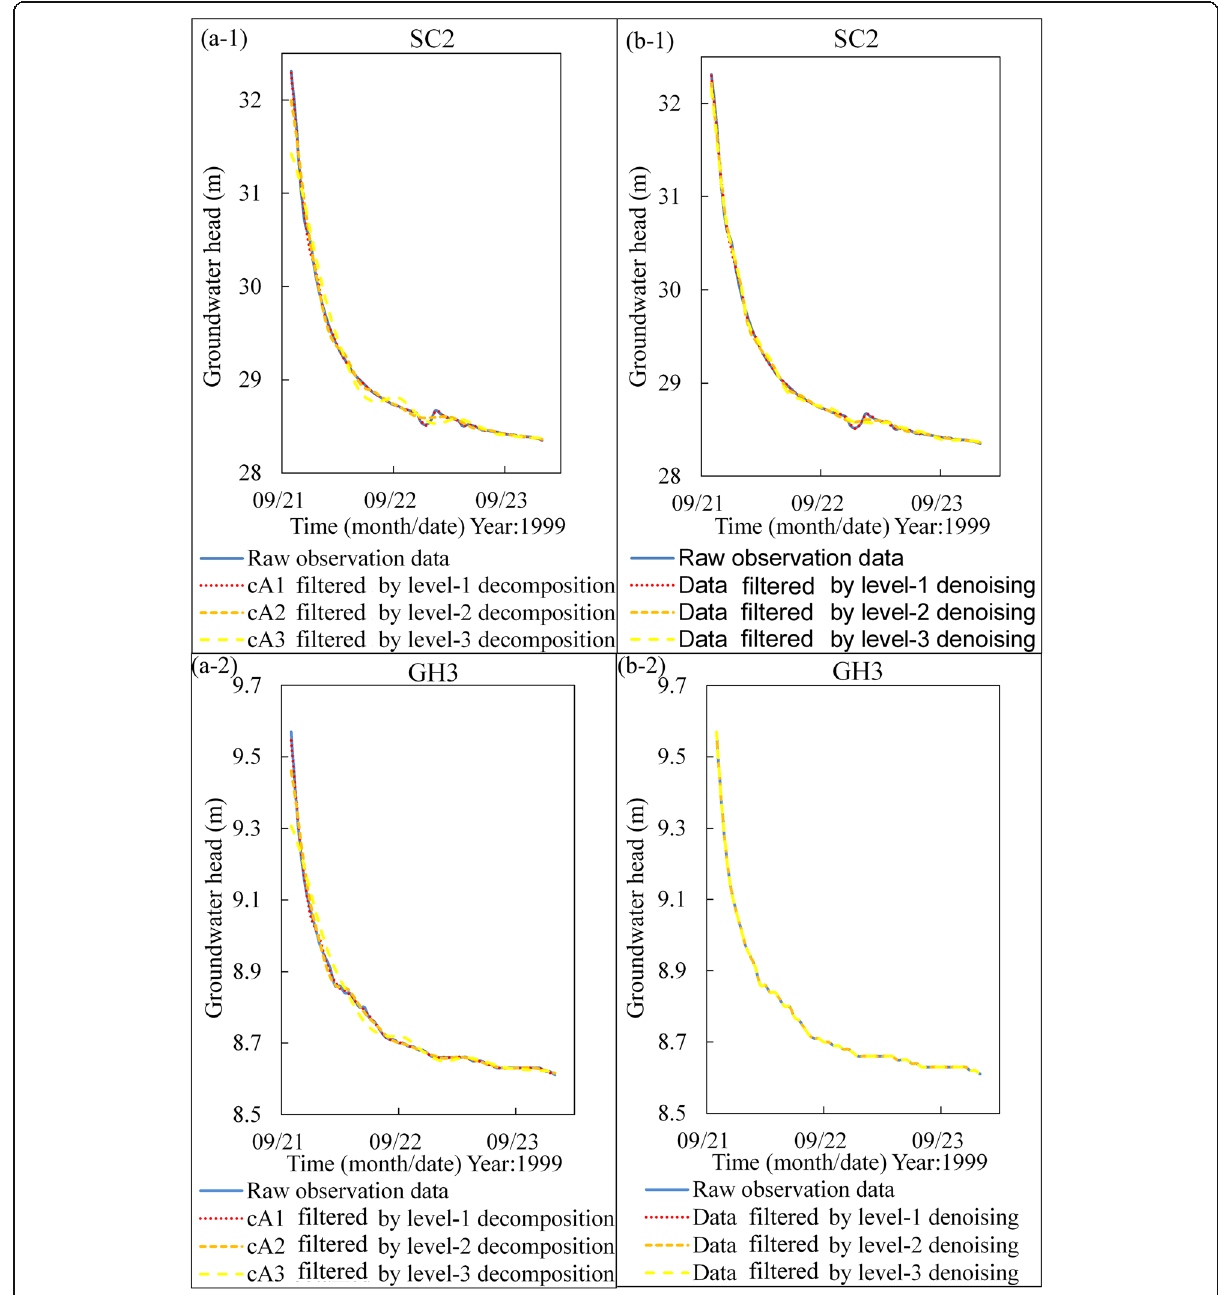
Fig. 14 Comparison of the post-seismic measured and decomposed groundwater head recessional hydrographs by using the a wavelet transform and b wavelet de-noising for (-1) SC2 and (-2)